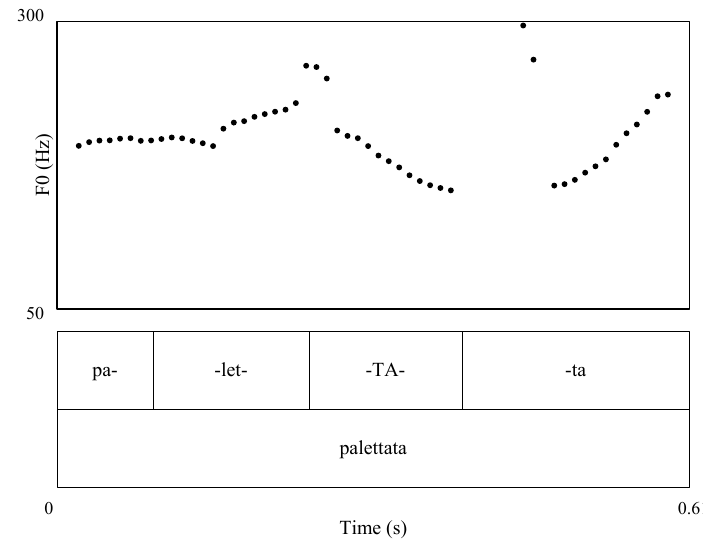
Figure 10. Low rising contour for questioning repeats, produced by Orfeo in Extract